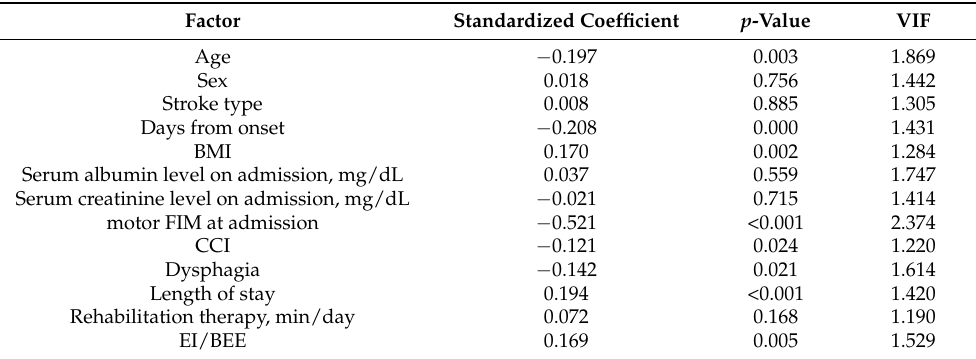
Table 3. Multivariate analysis of motor FIM gain (model